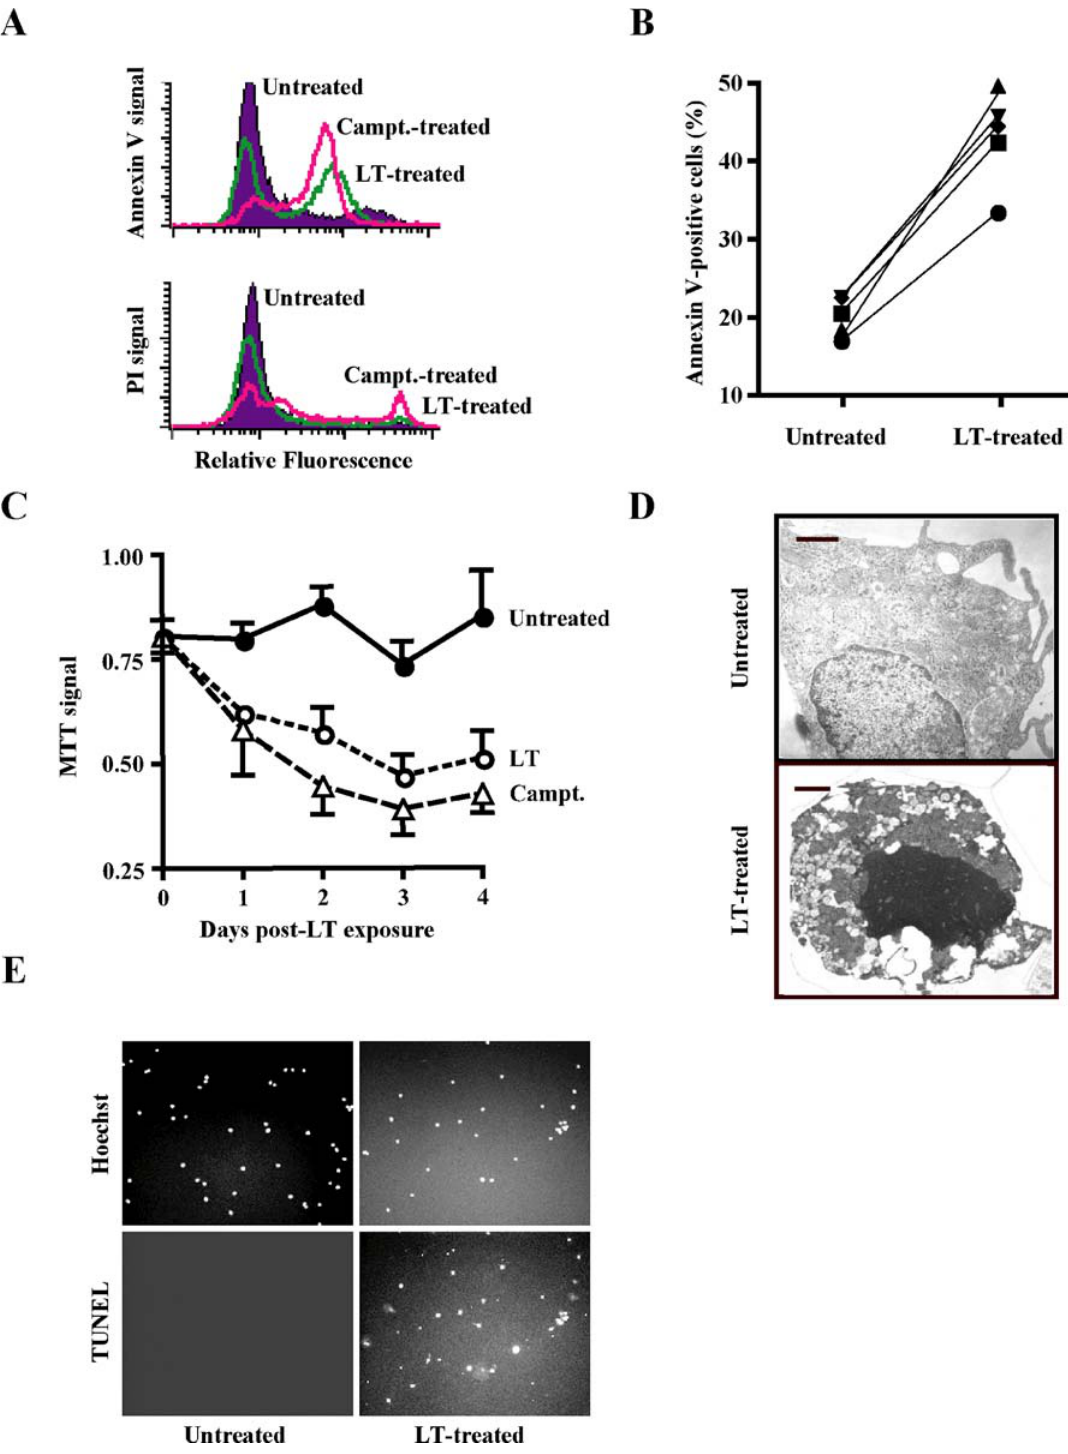
Figure 2. Killing of Human DCs by LT (A) MoDCs from a representative human subject were treated with LT (500 ng/ml PA and 250 ng/ml LF) or 10 l M camptothecin (Campt.) as a positive control, and annexin V/PI staining was measured by flow cytometry 48 h post-LT exposure. (B) Percentages of annexin V-positive untreated and LT-treated MoDCs from five different subjects were determined by flow cytometry 48 h post-LT exposure. (C) MTT assay of LT or camptothecin-treated human MoDCs. Mean þ standard deviation from three independent experiments are shown. (D) LT-treated human MoDCs show signs of apoptotic cell death, as analyzed by electron microscopy 48 h post-LT exposure. Bars: 1 l m. (E) Human MoDCs were TUNEL-positive 48 h post-LT exposure. Untreated and LT-treated MoDCs were subjected to TUNEL and Hoechst staining. DOI: 10.1371/journal.ppat.0010019.g002